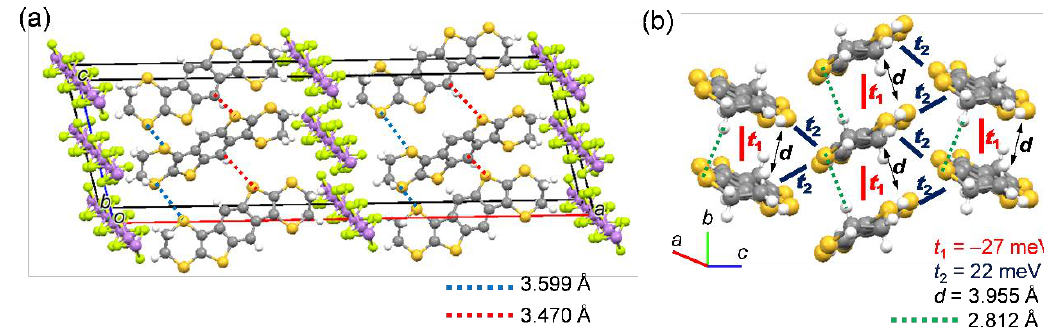
Figure 1. Crystal structures of (BEDT-BDT)AsF 6 at 270 K. ( a ) Molecular arrangements of the donor and anion layers. ( b ) Donor arrangement in θ -(BEDT-BDT)AsF 6 (the solid lines show the intermolecular transfer integrals; the AsF 6 anions are omitted for clarity).